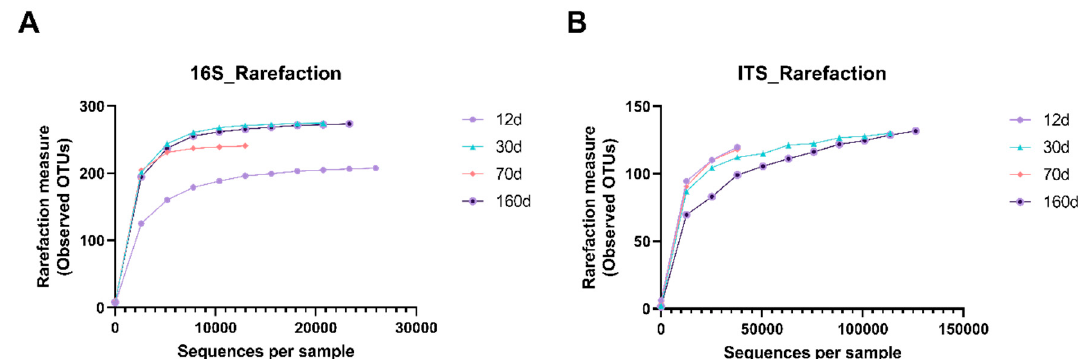
Figure 1. Rarefaction plots of the microbial ( A ) and mycobial ( B ) communities on the surface of dry-aged beef with respect to the aging periods. Rarefaction curves display the number of operational taxonomic units (OTUs) detected based on the sampling intensity of the libraries. ● , day 12; ▲ , day 30; ♦, day 70; and ● , day 160.